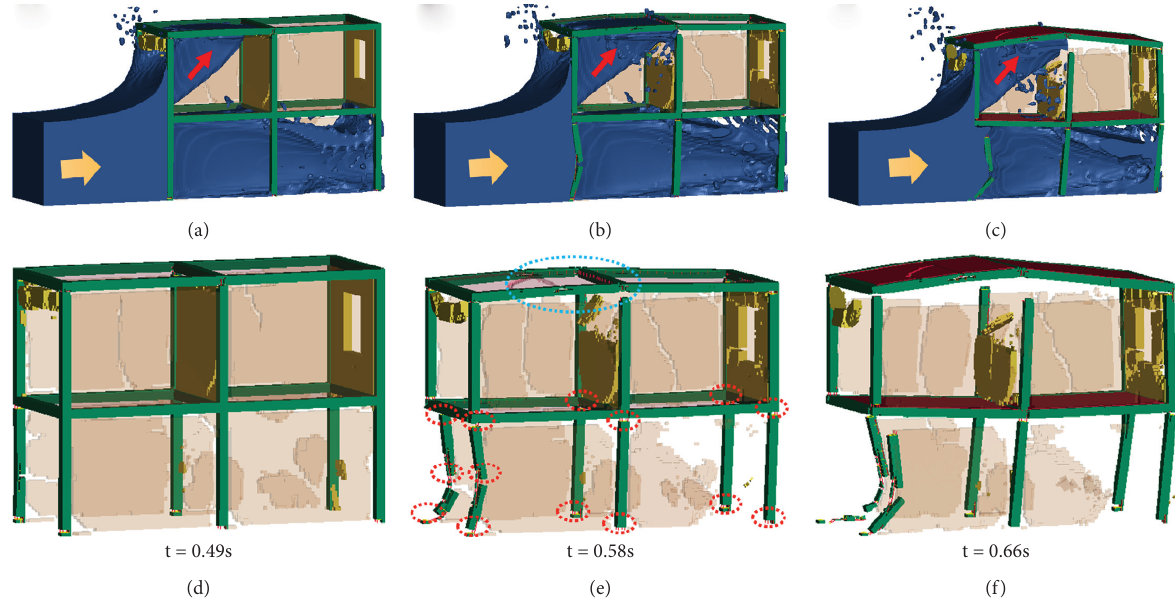
Figure 9: Snapshots in the scenario of s � 1, h � 3.2m, and v � 20.0m/s (one